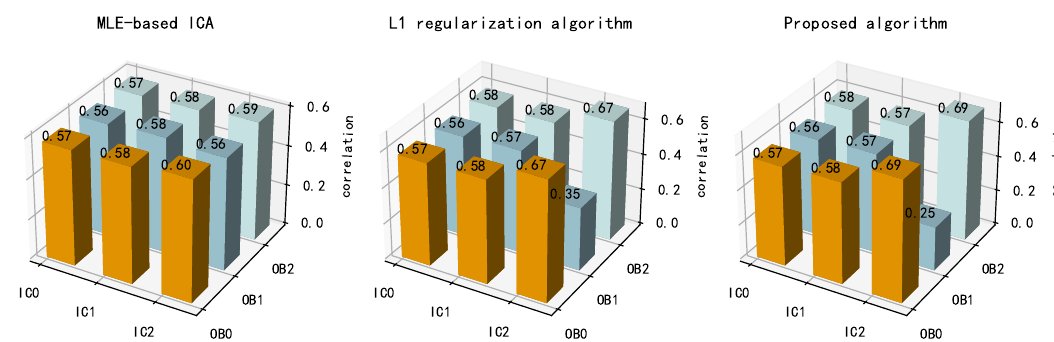
Figure 21. Changes in during the training process for each algorithm.